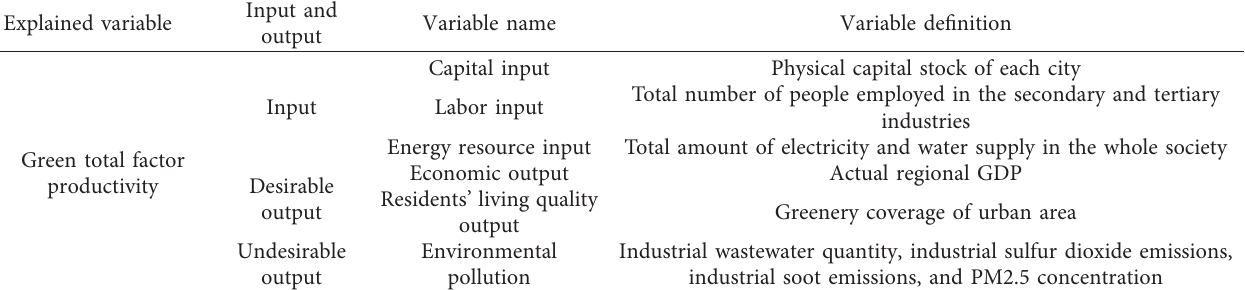
Table 1: Green total factor productivity.